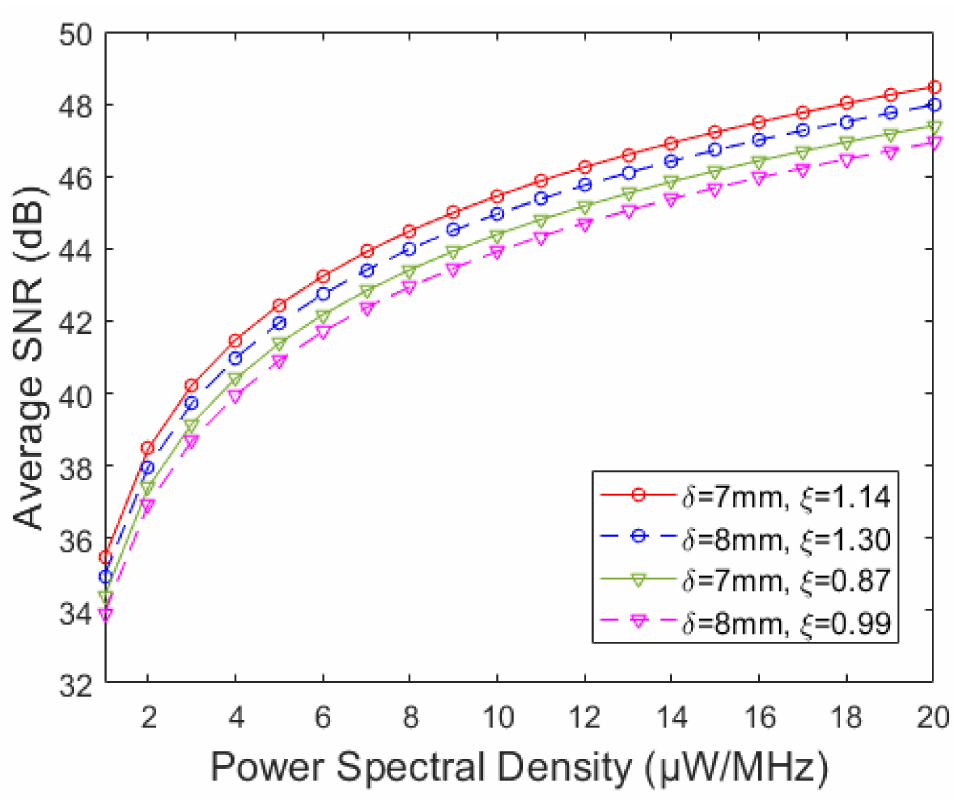
Figure 4. Average SNR evolution over a wide range of power spectral density of the transmitted signal for various generalized pointing errors strength and skin